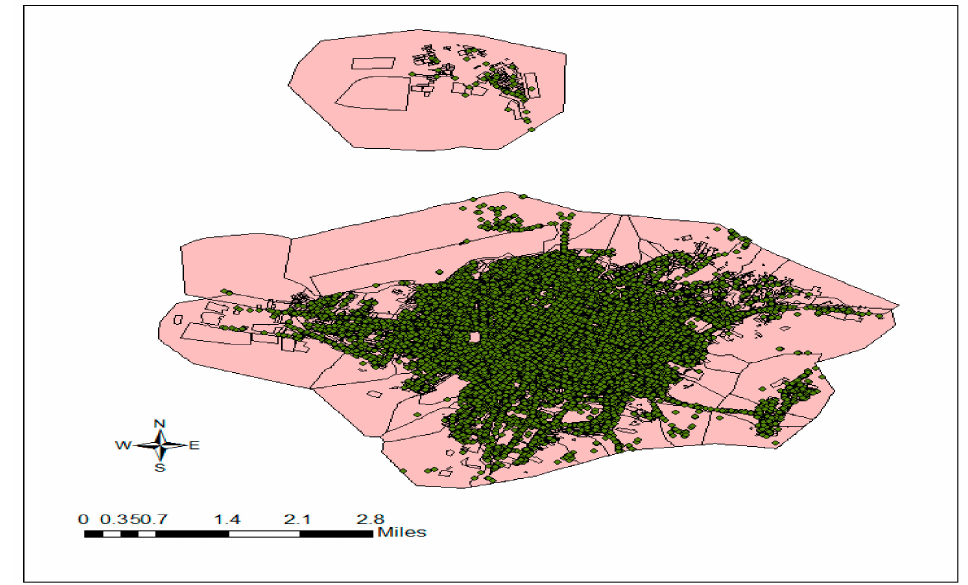
Figure 3. Spatial distribution of pick-up and drop-off